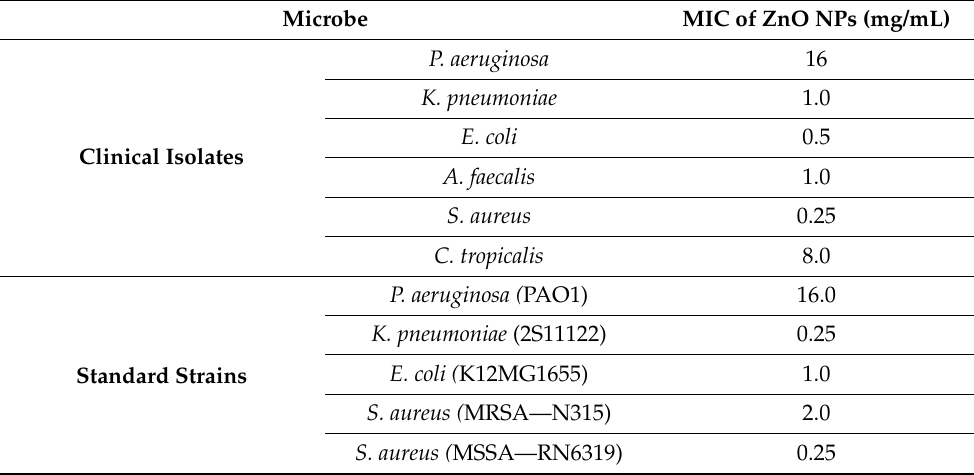
Table 3. Minimum inhibitory concentration of ZnO nanoparticles (ZnO NPs) against the isolated strong biofilm selected isolates with reference to standard